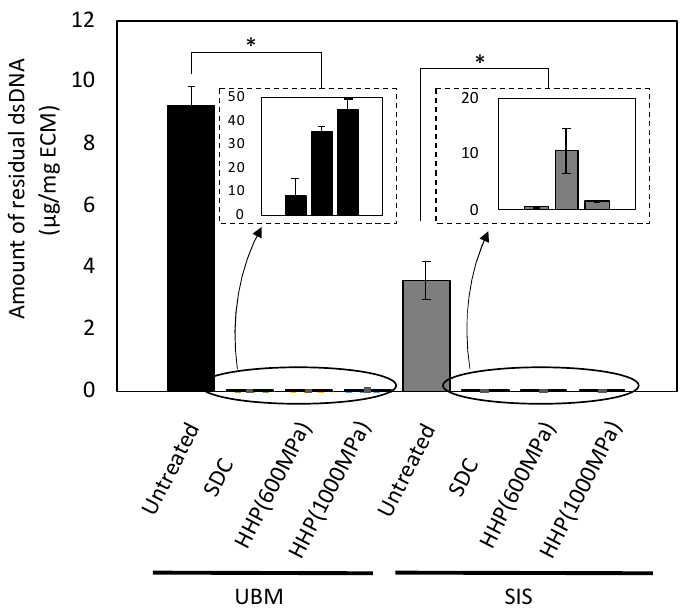
Figure 1. Quantitative analysis of residual double stranded DNA (dsDNA) in decellularized tissue. * p < 0.005. SDC and HHP represent the method of decellularization of each tissue (urinary bladder matrix (UBM) and small intestine submucosa (SIS)).